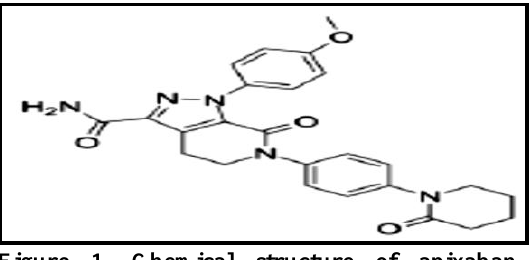
Figure 1. Chemical structure of apixaban (APX) (6)